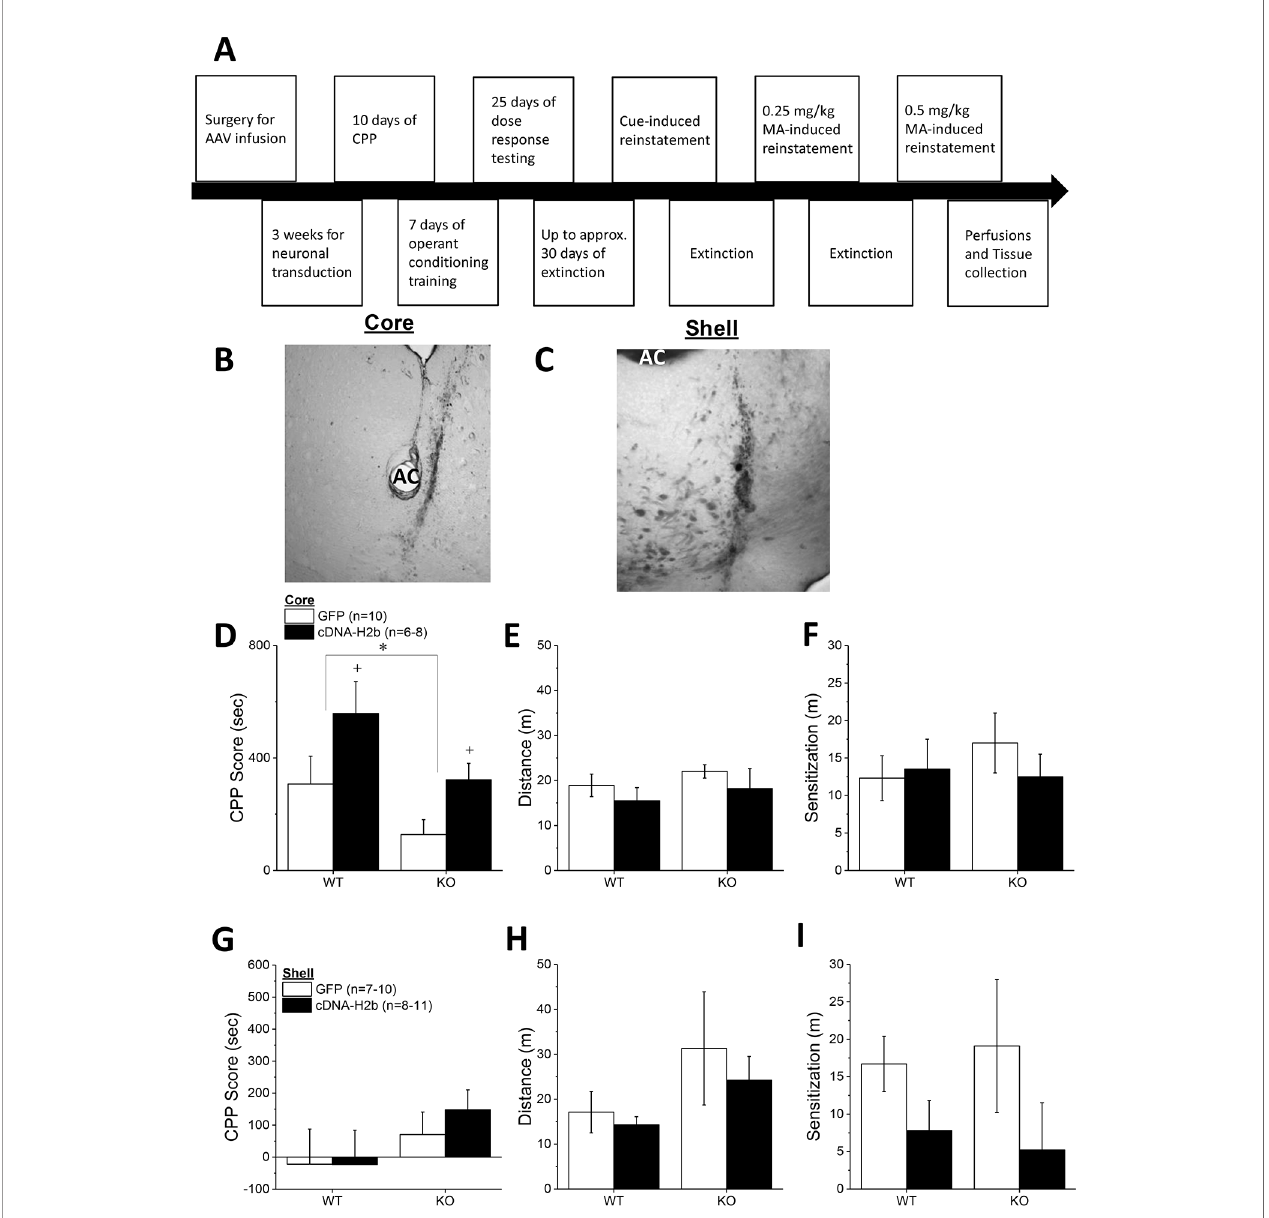
FIGURE 5 | Homer2b overexpression in the nucleus accumbens (NAC) core, but not NAC shell, potentiates a methamphetamine (MA)-induced conditioned place- preference (CPP). (A) The procedural time-line for the study examining the effects of cDNA-mediated overexpression of Homer2b within the NAC core and shell. Representative micrographs of the neuronal transduction within the NAC core (B) and NAC shell (C) by antihemagglutinin (HA)-tagged adeno-associated viral vector (AAV)-cDNA encoding Homer2b (images at 20 X magni fi cation). AC, anterior commissure. (D) The magnitude of a MA-induced CPP was lower in Homer2 knockout (KO) mice versus wild-type (WT) controls and cDNA infusion into the NAC core potentiated MA-induced place conditioning in both genotypes, without affecting the (E) acute or (F) sensitized locomotor response to MA. No genotypic difference or cDNA effect were apparent for (G) MA-induced CPP, (H) the acute locomotor response to MA or (I) the magnitude of MA-induced locomotor sensitization, when the cDNA was infused into the NAC shell. The data represent the means ± SEMs of the number of mice indicated in Panel C for NAC core and Panel F for NAC shell. *p < 0.05 vs. WT; + p < 0.05 vs. hole responding (AAV effect and interactions, p ’ s > 0.22). In mice infused intra-NAC shell, response allocation progressively ( Figure 6D ) and the Genotype X Day interaction failed to increased across day, irrespective of the genotype or AAV reach statistical signi fi cance [Day effect: F(4,128) = 4.79, p = treatment ( Figure 6E ) [Day effect: F(4,128) = 8.80, p < 0.0001; 0.001; Genotype X Day, p = 0.095]. However, as observed for the no interactions with the Day factor, p ’ s > 0.25]. However, in NAC core, intra-NAC shell cDNA infusion did not alter active